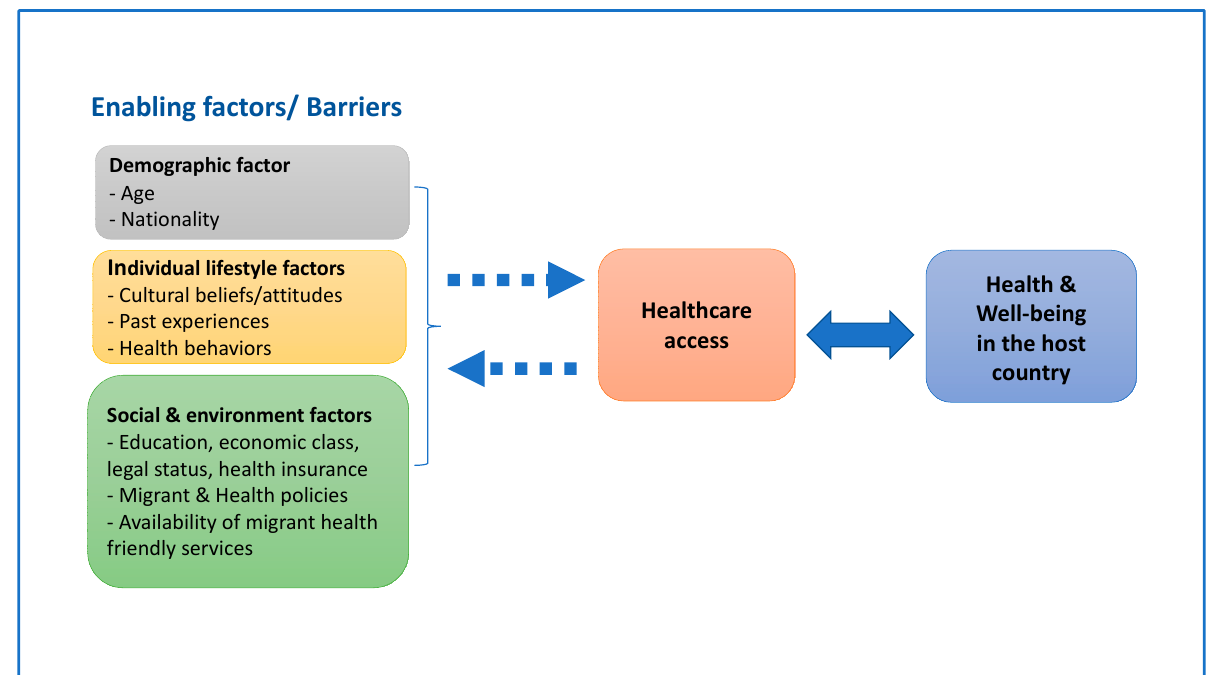
Figure 1. Conceptual framework for guiding the interviews and focus group discussions.